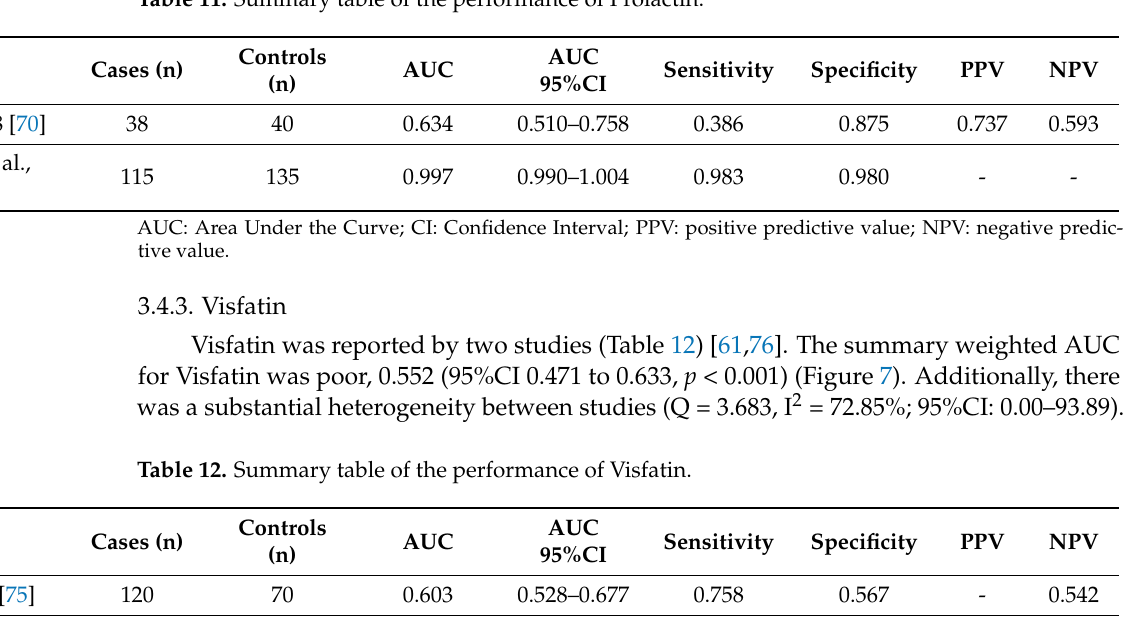
Table 11. Summary table of the performance of Prolactin.